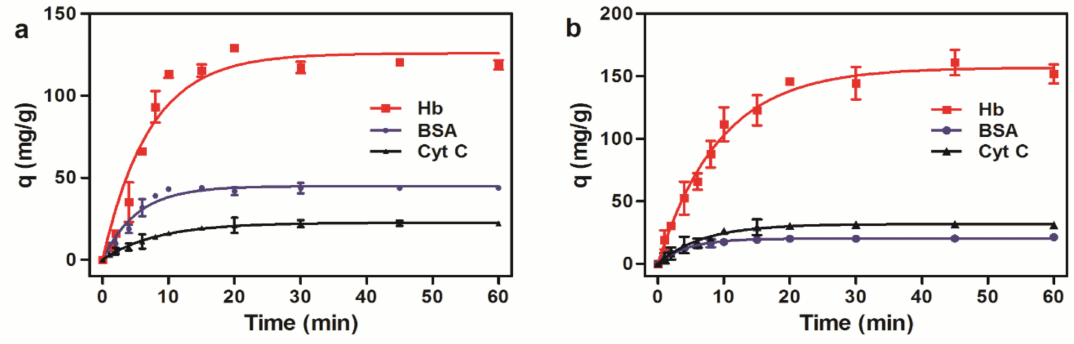
Figure 8. Adsorption kinetics of three proteins to magnetic microspheres. ( a ) Amino magnetic microspheres. ( b ) Carboxyl magnetic microspheres.